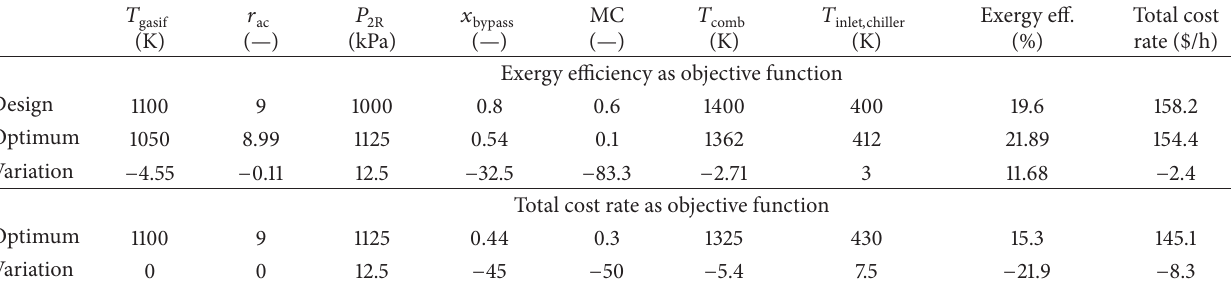
Table 6: Optimization results of multigeneration